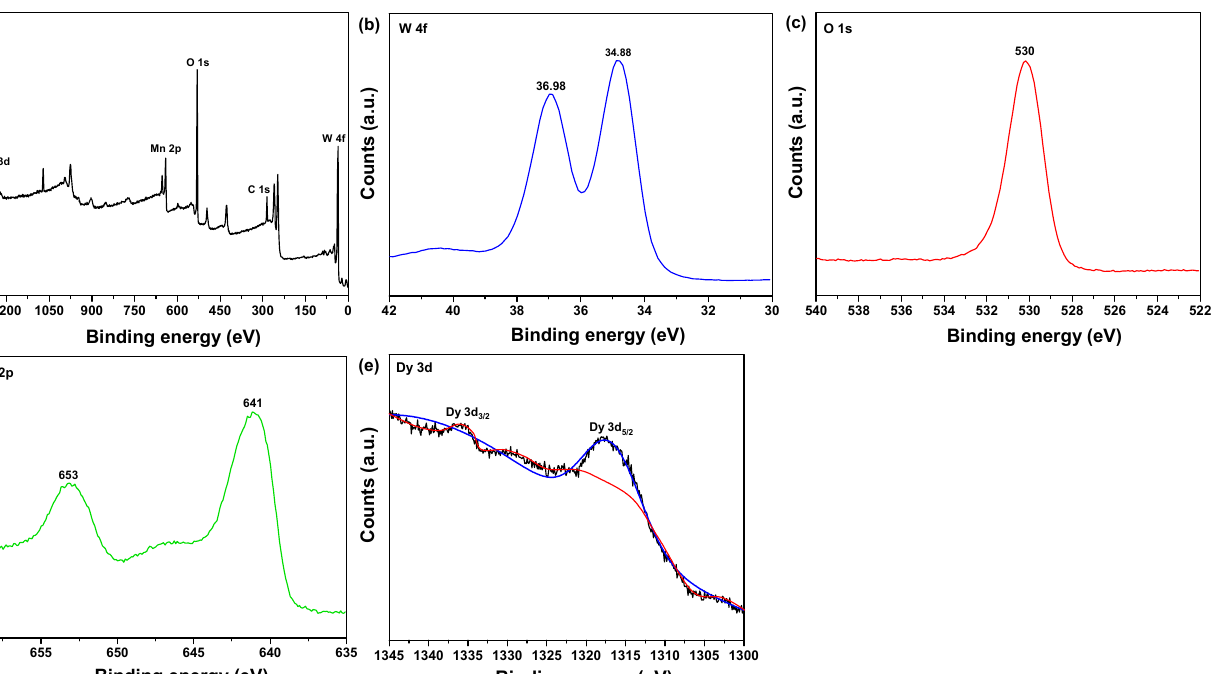
Figure 4. ( a ) Raman shift of MnWO 4 and MnWO 4 :Dy 3+ , ( b ) magnetization properties of MnWO 4 :Dy 3+ performed at room temperature, and ( c ) scale of M(10 kOe) vs. Dy 3+ ions content. To determine MnWO 4 :Dy 3+ samples of binding energy, oxidation, and chemical state, XPS analysis was performed on MnWO 4 :Dy 3+ (Figure 5). Results show Mn 2p; two peaks can be observed corresponding to Mn 2p 3/2 and Mn 2p 1/2 at 641 eV and 653 eV, respectively. This indicates that the Mn present in the sample is in +2 oxidation state [24]. The XPS spectrum of W 4f is shown in Figure 5b. It has two peaks, corresponding to W 4f 7/2 and W 4f 5/2 at 34.88 and 36.98 eV, respectively. The W 4f 7/2 and W 4f 5/2 doublets’ spin-orbit is at 2.1 eV, and the oxidation state of W can be specified as +6 [25]. The O 1s peak shows a main component with a central energy of 530 eV and a lower binding energy, which monitored to the formation of O 2 oxide-coupled manganese and tungsten elements (Mn–O–W), as shown in Figure 5c. In Figure 5e, the RE 3+ 3d spectrum can be observed for the MnWO 4 sample doped with RE 3 + . The Dy 3+ 3d spectrum is visible at 1317 eV and 1335 eV; these can be assigned to the RE 3+ 3d 5/2 and 3d 3/2 states, respectively, based on the Dy–O bond [26].